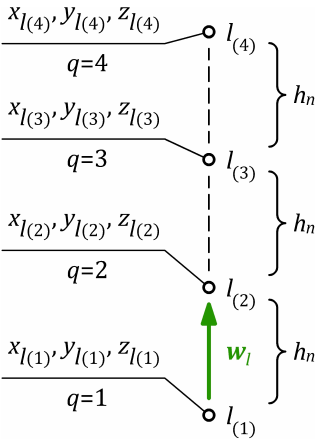
Figure 5: Diagram of a fourfold replication of node number l (1) .